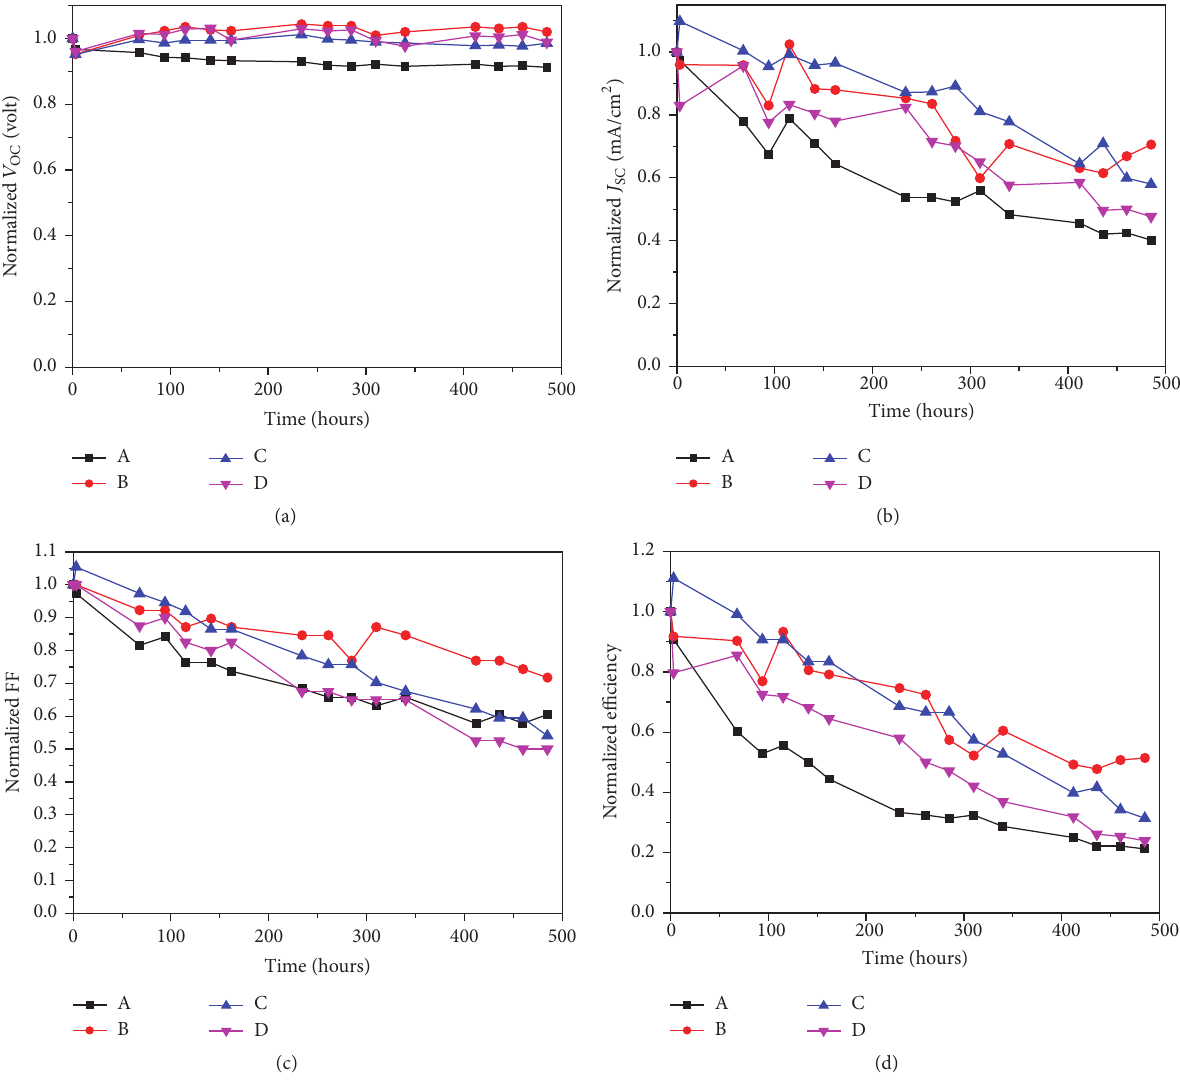
Figure 6: ISOS-L-1 study of PCPDTTBTT solar cell under standard solar irradiation of 100mW/cm 2 (AM1.5G); (a) normalized 𝑉 time plot of PCPDTTBTT solar cell of the following: A: without thermal annealing, B: thermal annealing at 80 ∘ C, C: thermal annealing